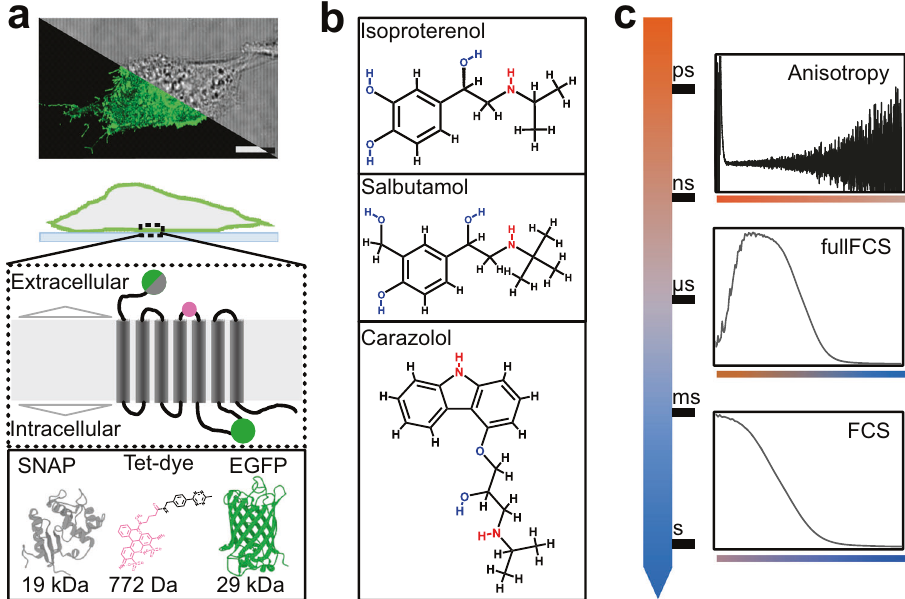
Fig. 1 Fluorescence spectroscopy resolves membrane receptor mobility. a CHO-K1 cells were grown on glass coverslips (top, fl uorescent confocal maximum intensity projection vs. bright fi eld illumination) and transiently transfected with four different β 2 -AR constructs (middle) carrying three differently sized fl uorophores (bottom): N-terminal EGFP or SNAPtag, EGFP at the intracellular loop 3 or Me-Tet-ATTO488 coupled to the unnatural amino acid trans -cycloctene (TCO) at position 186 ( β 2 -AR A186TCO ). b Structures of agonist (isoproterenol, ISO), partial agonist (salbutamol, SAL) or inverse agonist (carazolol, CAR) used in this study to compare β 2 -AR diffusion dynamics upon their addition to probe for possible changes in oligomerization or protein clustering. c The combination of three different time resolved spectroscopy experiments with overlapping temporal resolution allows to probe the translational and rotational dynamics in the range from ps to sec; Time-resolved anisotropy (TRA, top) is sensitive to rotation in the ps to the ns range, Fluorescence correlation spectroscopy (FCS, bottom) probes dynamics in the range from µ s to s, while continuous-wave FCS (fullFCS, middle) covers a broad range from ps to